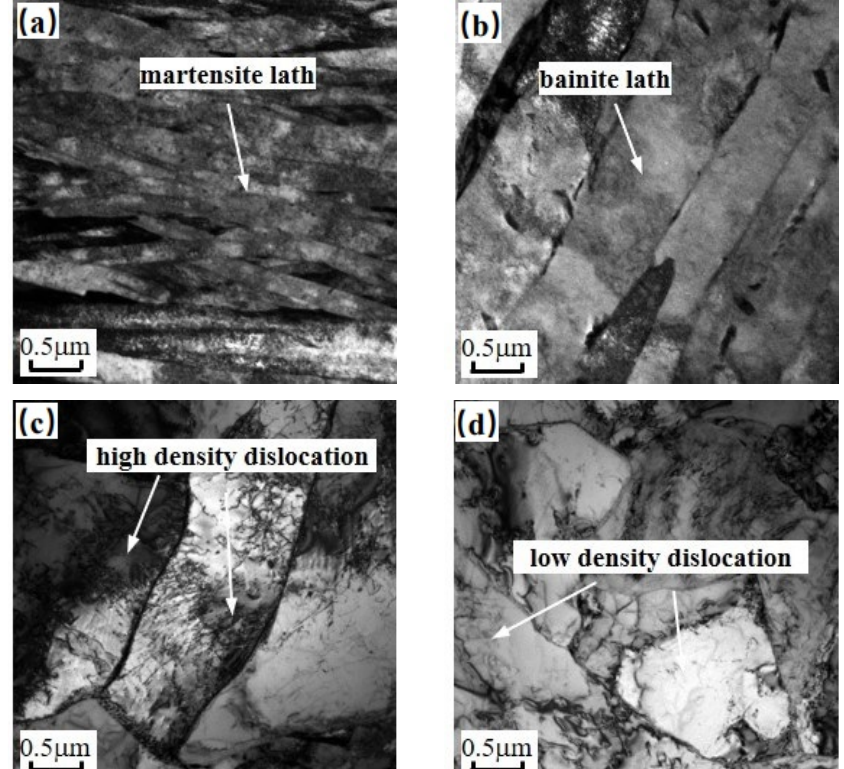
Figure 8. TEM micrographs of different regions of the welded joint. ( a ) WS; ( b ) CGZ; ( c ) FGZ; ( d ) BM.